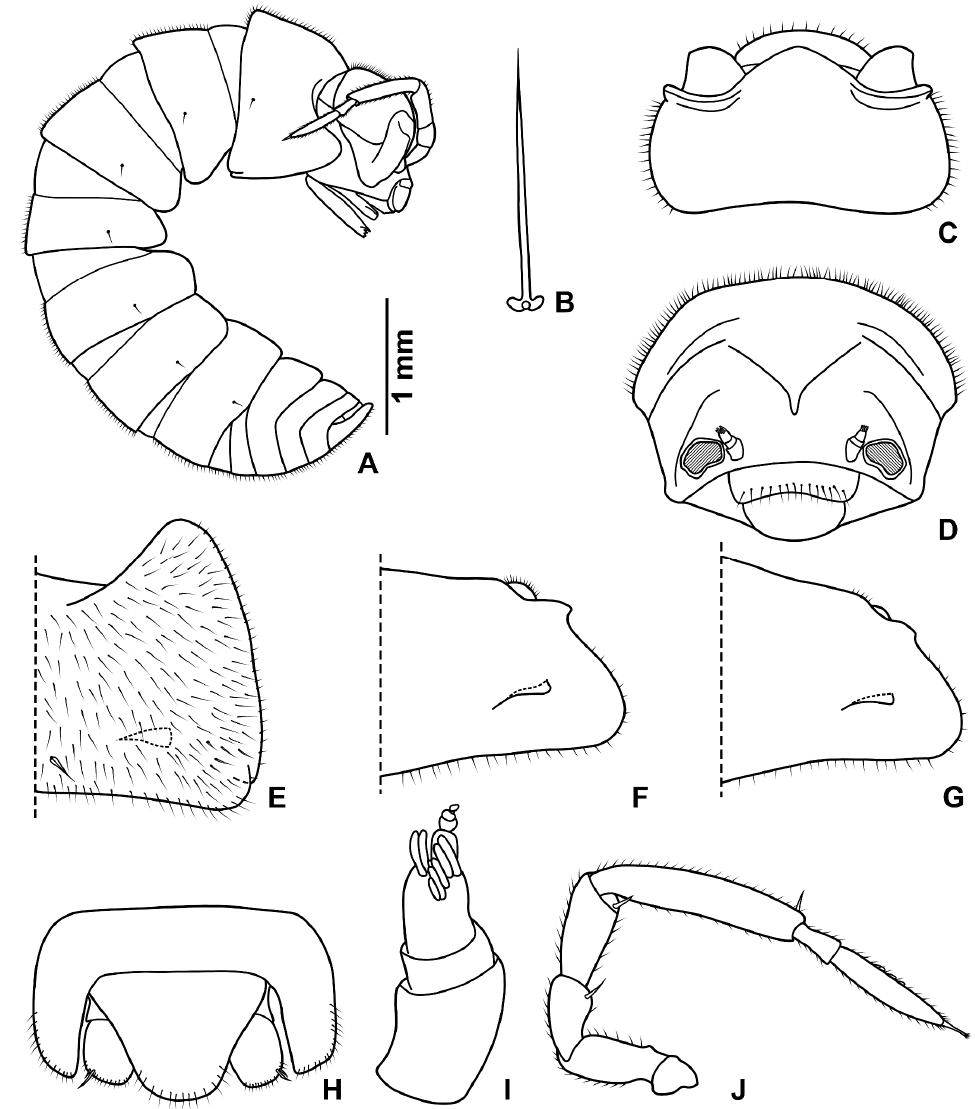
Figure 13. Alloschizidium segestanum sp. n., paratype ♀ from Punta Manara. ( A ) Specimen in lateral view, showing disposition of noduli laterales. ( B ) Dorsal scale-seta. ( C ) Cephalon, dorsal view. ( D ) Cephalon, lateral view. ( E ) Epimeron of pereonite 1, dorsal view. ( F ) Epimeron of pereonite 2, ventral view. ( G ) Epimeron of pereonite 3, ventral view. ( H ) Pleonite 5, telson and uropods, dorsal view. ( I ) Antennula. ( J ) Antenna.